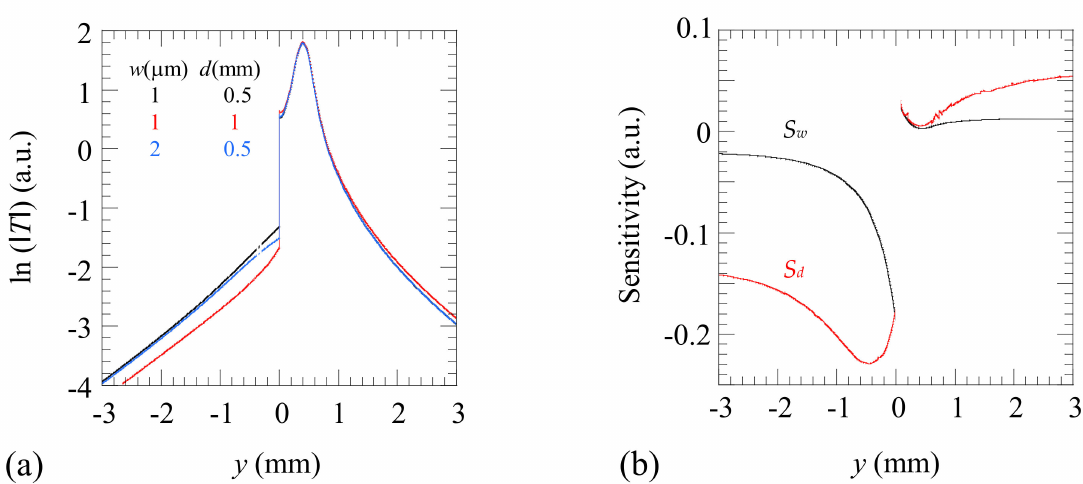
Figure 4. ( a ) Simulation of ln(| T |) as a function of the transverse distance to the crack, which is located at y = 0. Simulations have been performed for an Al-alloy sample ( D = 42 mm 2 /s, K = 100 W m − 1 K − 1 ) with the same experimental parameters as in Figure 2: P o = 1 W, f = 5 Hz, a = 0.2 mm, and l = 0.4 mm. Three couples of ( w , d ) are plotted. ( b ) Simulation of the sensitivity of ln(| T |) to w and d for the same